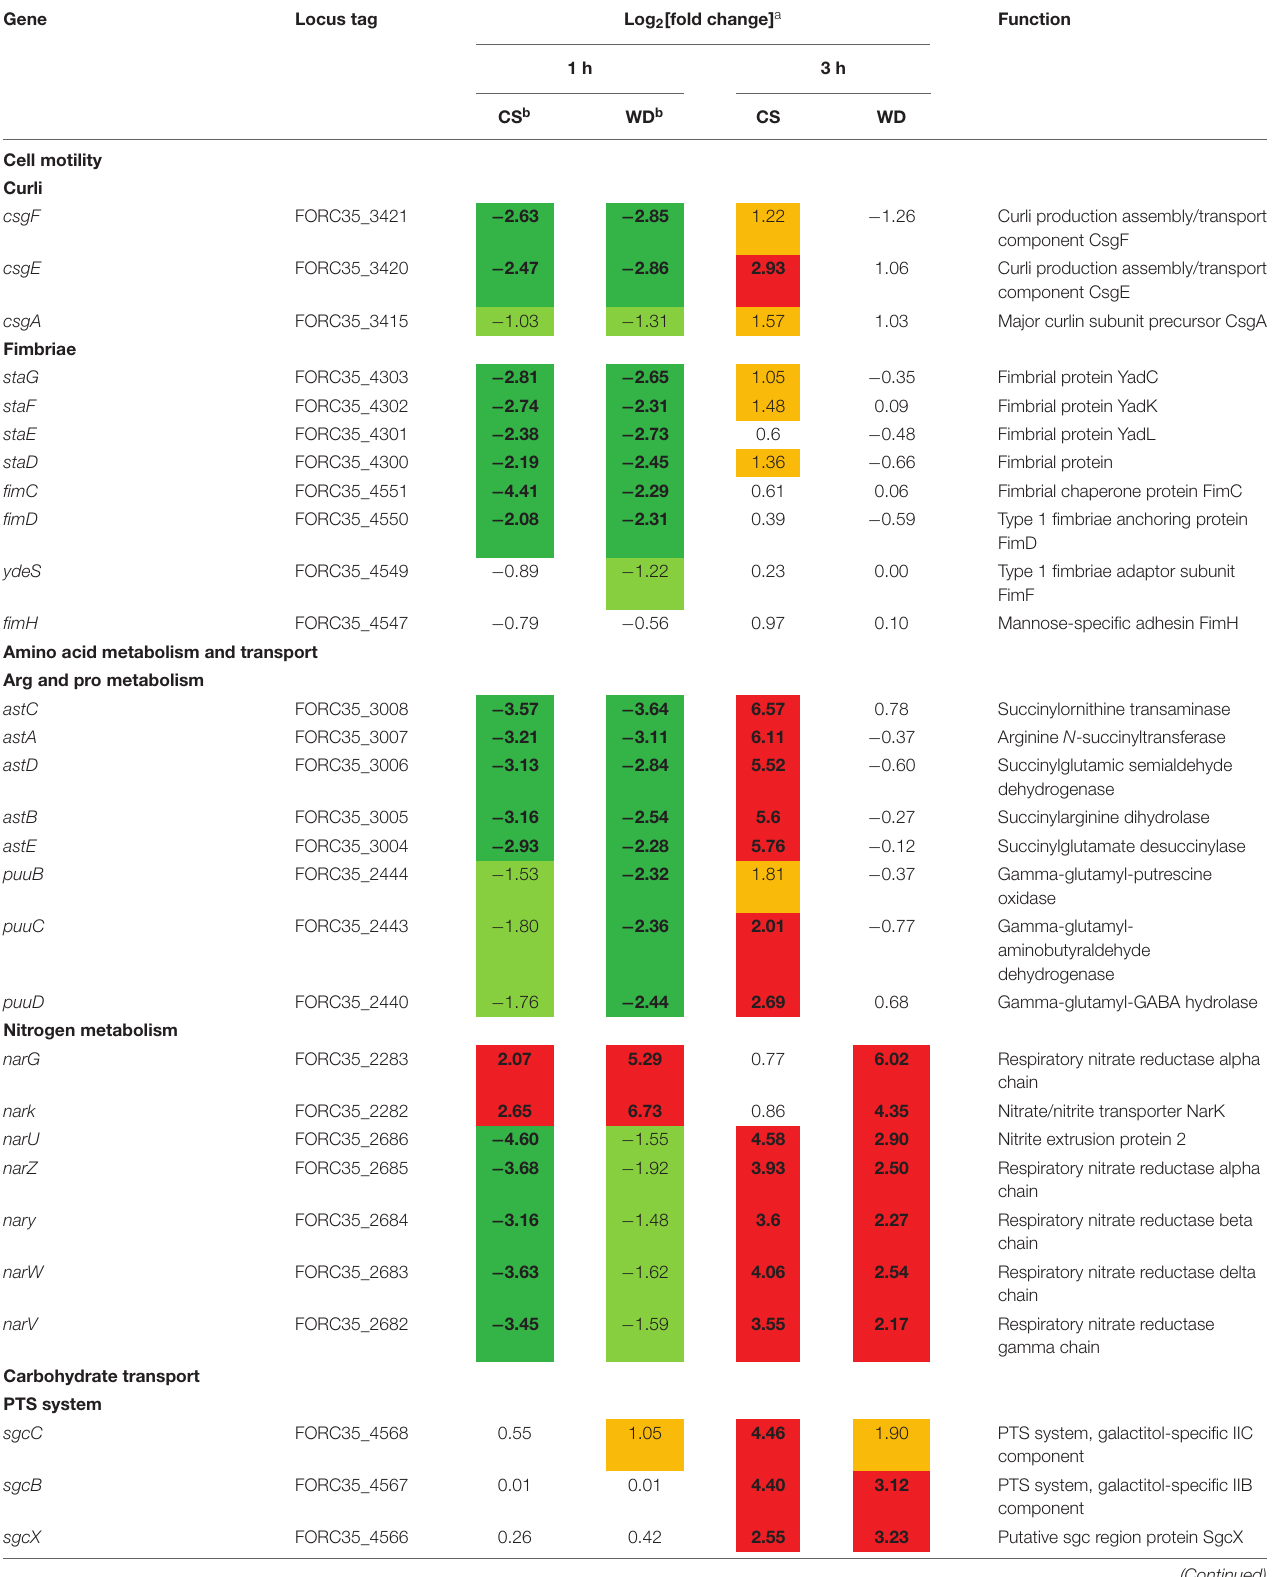
TABLE 2 | Genes specifically regulated by exposure to fresh